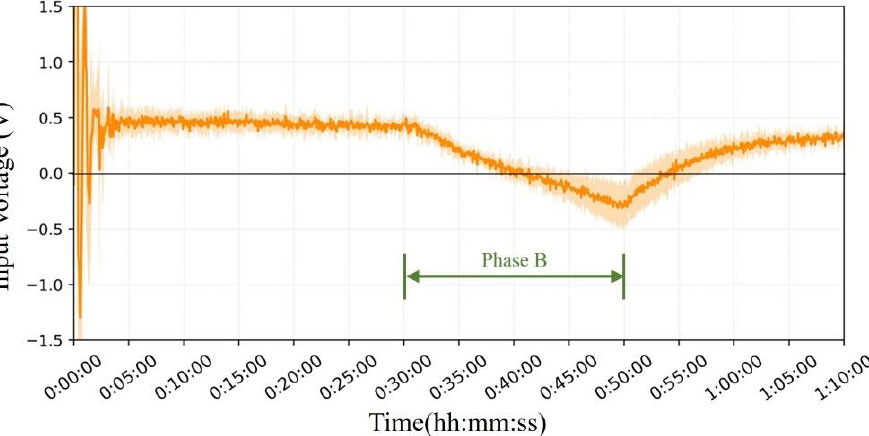
Figure 11. Average input voltage V Input of the Peltier module with the error band for seven subjects.